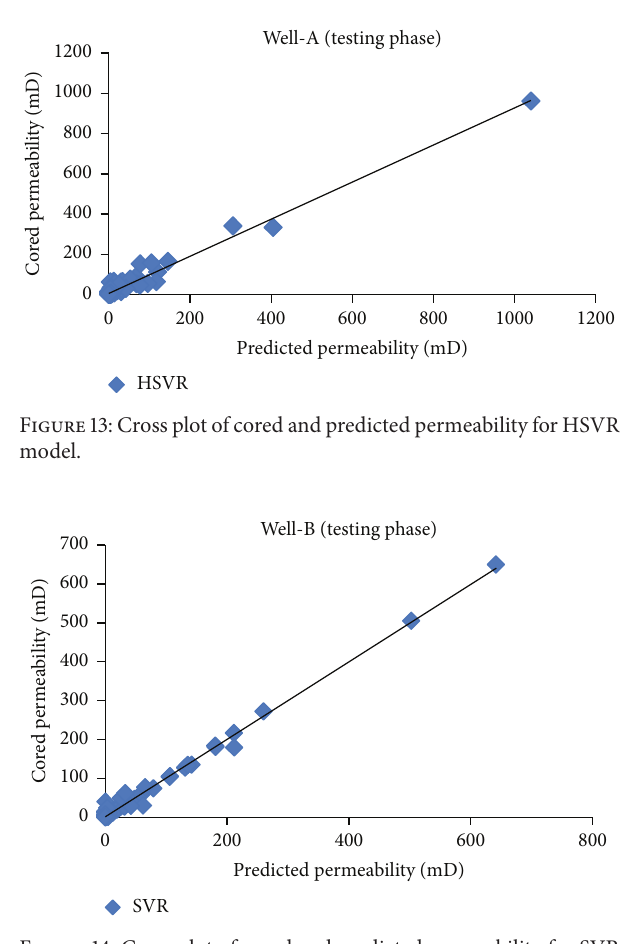
Figure 14: Cross plot of cored and predicted permeability for SVR model.